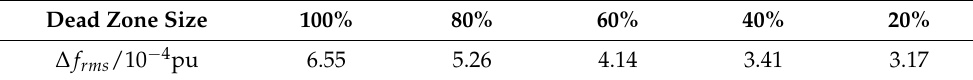
Table 2. Modulation evaluation indexes under different FM dead zones of energy storage.